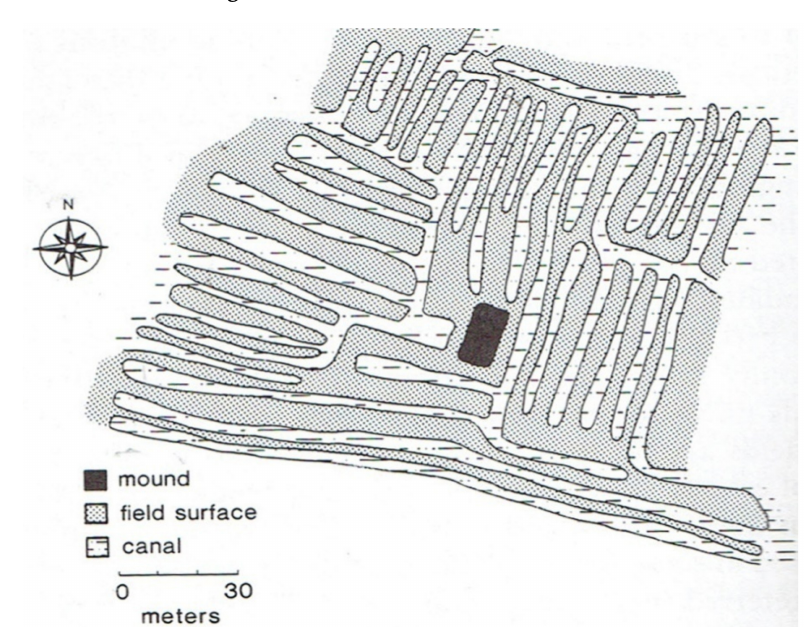
Figure 15. Lakaya sector raised-field geometry in the Pampa Koani